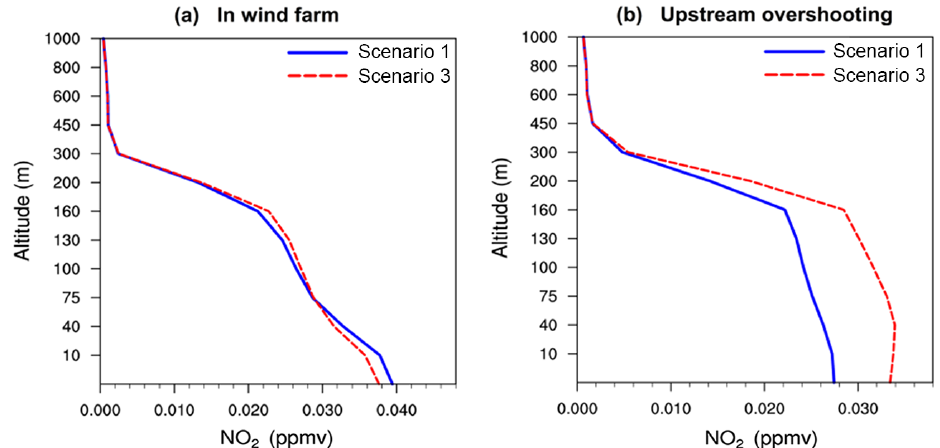
Figure 11. Vertical profiles of NO 2 concentration from the surface to the 1000m height from the control run (S1, solid blue line) and S3 run (red dashed line) at (a) the YWF grid (44, 52) at 21:00UTC on 19 November, and (b) the upwind grid (50, 48) at 22:00UTC on 19 November.